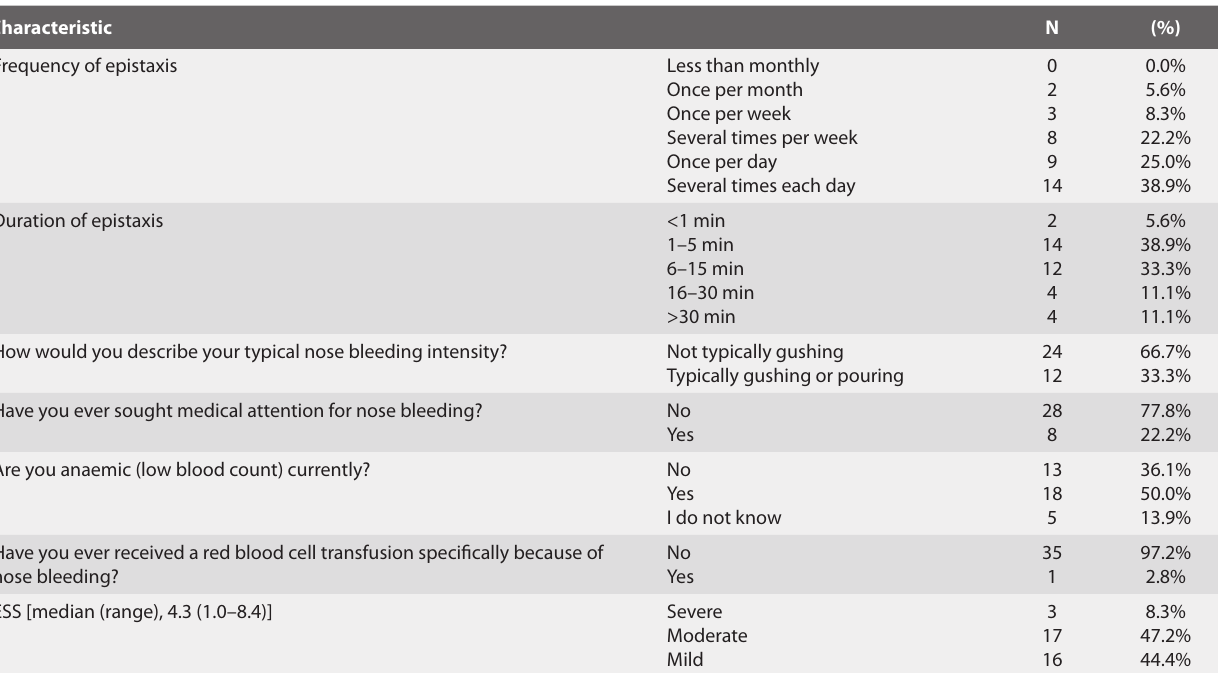
Table 2. Characteristics of epistaxis and normalised